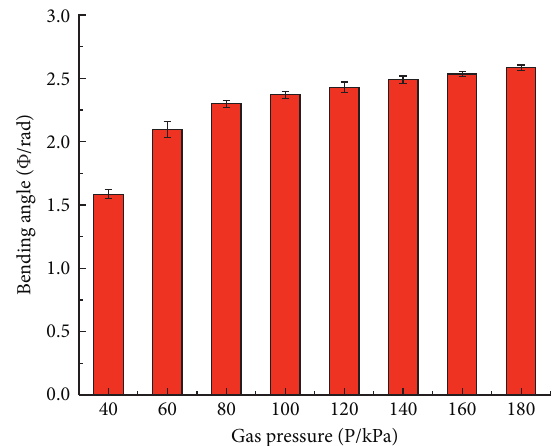
Figure 10: Error bar analysis of theoretical deformation model.